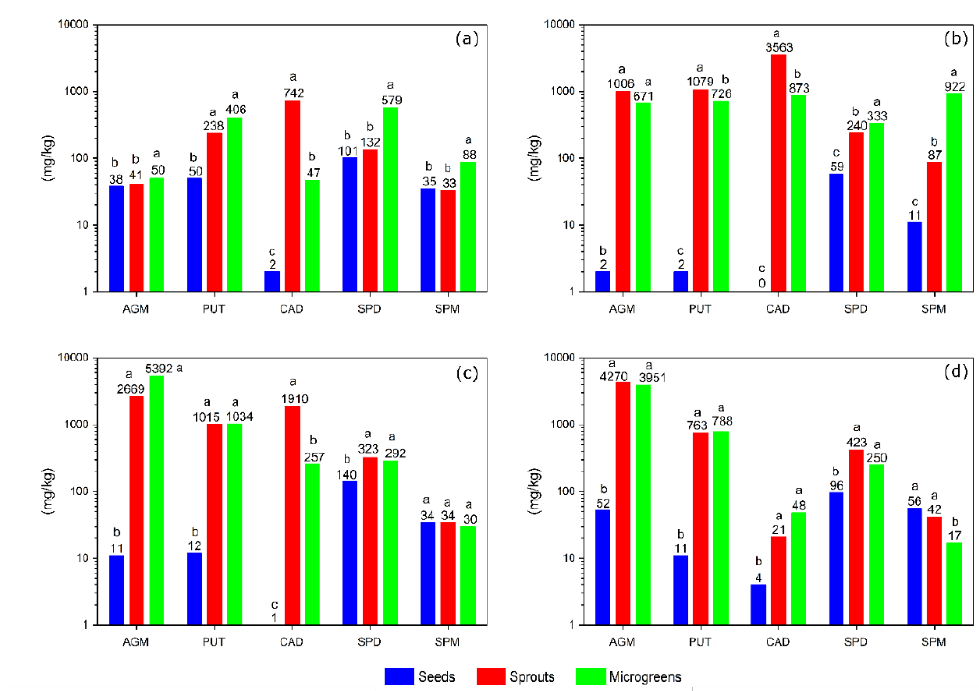
Figure 2. Content of the polyamines agmatine (AGM), putrescine (PUT), cadaverine (CAD), spermidine (SPD), and spermine (SPM) in seeds, sprouts and microgreens of ( a ) lentil, ( b ) fenugreek, ( c ) alfalfa, and ( d ) daikon radish. The data are presented on a logarithmic scale and expressed on a dry weight basis. When the content of a given polyamine in seeds, sprouts, and microgreens differs significantly, it is labeled with different letters.